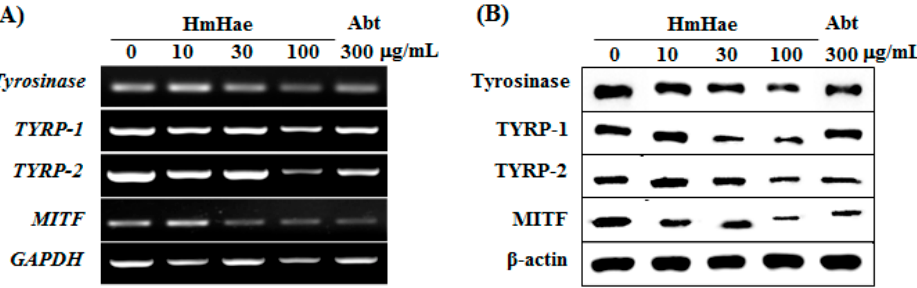
Figure 4. Effect of HmHae on the levels of melanogenesis-related mRNA and proteins in melan-a cells. ( A ) Cells (5 × 10 5 cells/mL) were cultured for 24 h; the medium was replaced with fresh medium containing the indicated concentration of HmHae or arbutin for 24 h. mRNA was extracted using TRIzol, and expression was analyzed by reverse-transcription polymerase chain reactions; and ( B ) cells (1 × 10 5 cells/mL) were cultured for 24 h; the medium was replaced with fresh medium containing the indicated concentrations of HmHae or arbutin for three days. Total cell lysate was extracted and assayed by Western blotting using antibodies against tyrosinase, TYRP-1, TYRP-2, and microphthalmia-associated transcription factor (MITF). Equal protein loading was confirmed using β -actin as a standard. Abt: arbutin.